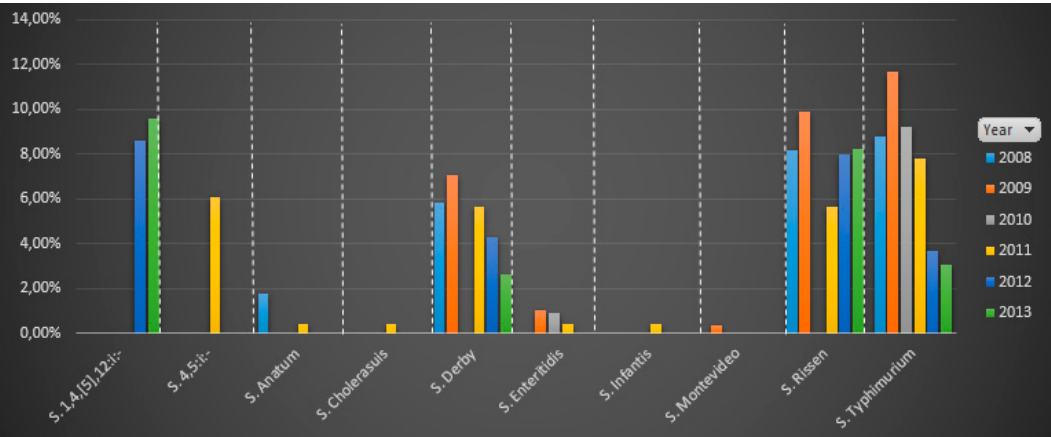
Figure 2. Distribution by serotype of the proportion of positive holdings to Salmonella (of total holdings tested per year) in slaughter pigs per year. This information is based on the annual Spain country reports (2008-2012).